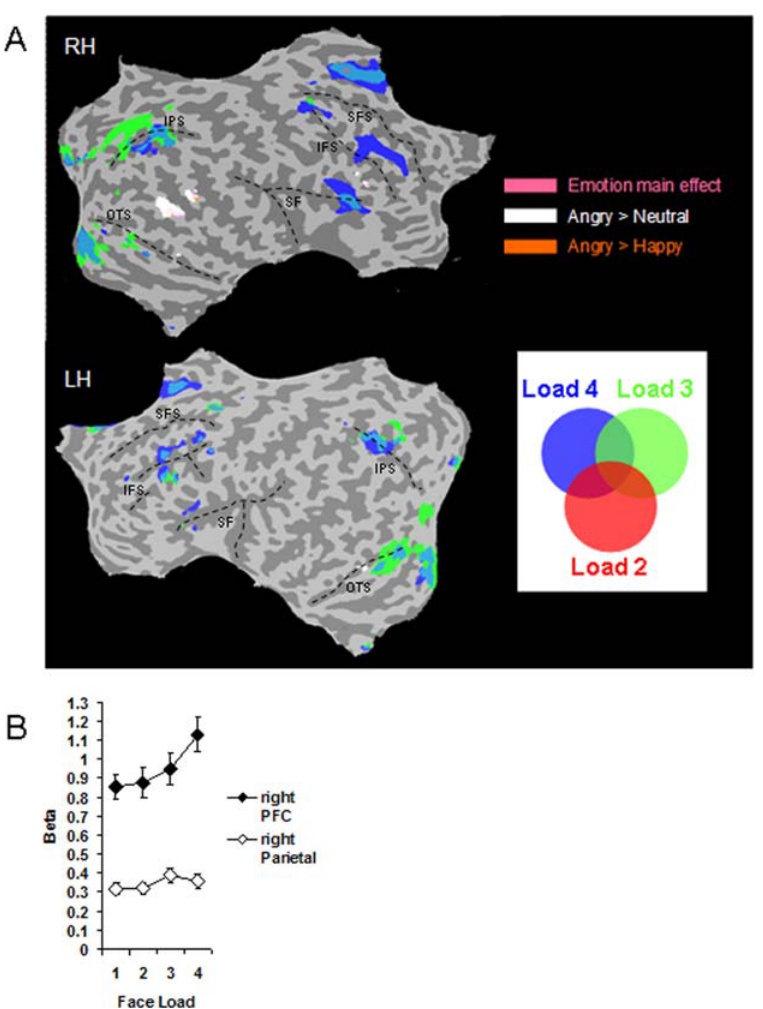
Figure 6. (A) Face loads 4 (blue), 3 (green), and 2 (red) were contrasted with face load 1. Several regions of the PFC, the frontal eye fields (FEF), inferior parietal sulcus (IPS), fusiform gyrus, and occipital cortex, in both left and right hemispheres, showed greater activity when multiple faces were to be remembered compared to just one face. Brain regions modulated by emotion in the right hemisphere (pink=emotion main effect; white=angry minus neutral contrast; brown=angry minus happy contrast) are overlain to illustrate the anatomical distinction between emotional expression and face load effects. Some anatomical landmarks are provided to aid navigation: superior frontal sulcus (SFS); inferior frontal sulcus (IFS); silvian fissure (SF); inferior parietal sulcus (IPS); occipito-temporal sulcus (OTS). (B) Beta values from each load condition (averaged across emotions) illustrate the contrast between a monotonic increase of activity with load in right PFC (x=41, y=29, z=26) and peaked activation at load 3 in right parietal cortex (x=18, y= 2 69, z=43). Bars represent 6 1 standard